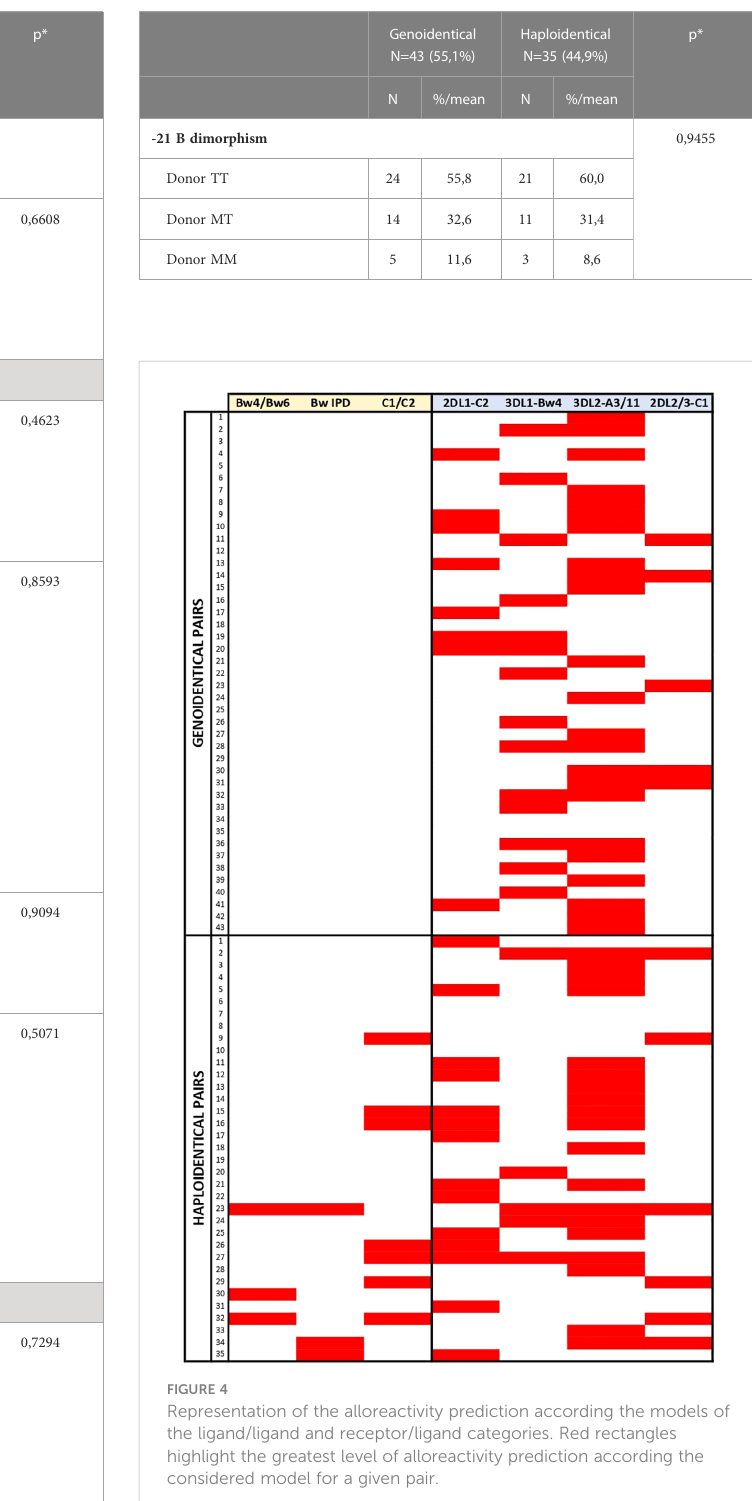
FIGURE 4 Representation of the alloreactivity prediction according the models of the ligand/ligand and receptor/ligand categories. Red rectangles highlight the greatest level of alloreactivity prediction according the considered model for a given pair. The most striking correlations are highlighted in the following subsections.